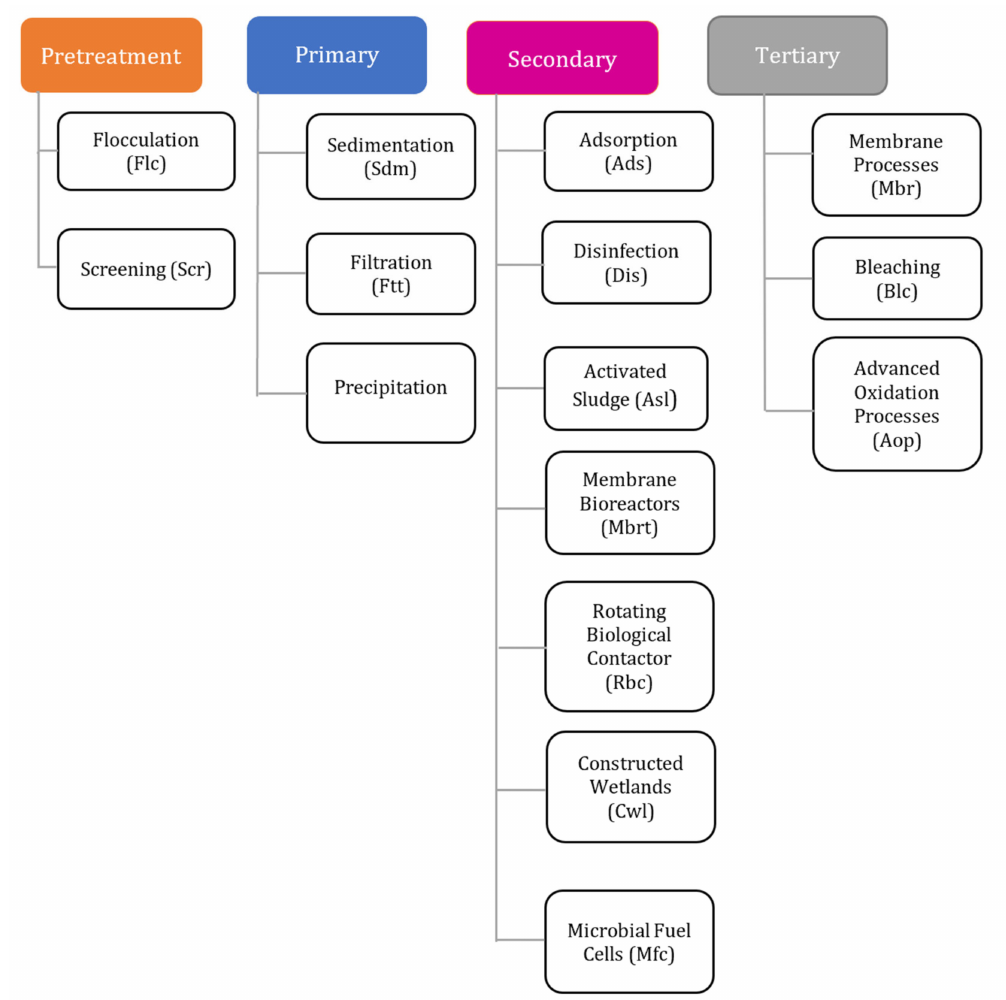
Figure 2. Stage-wise WWT and some typical technologies. Technologies are classified based on their efficiencies, driving force for separation, and type of contaminant